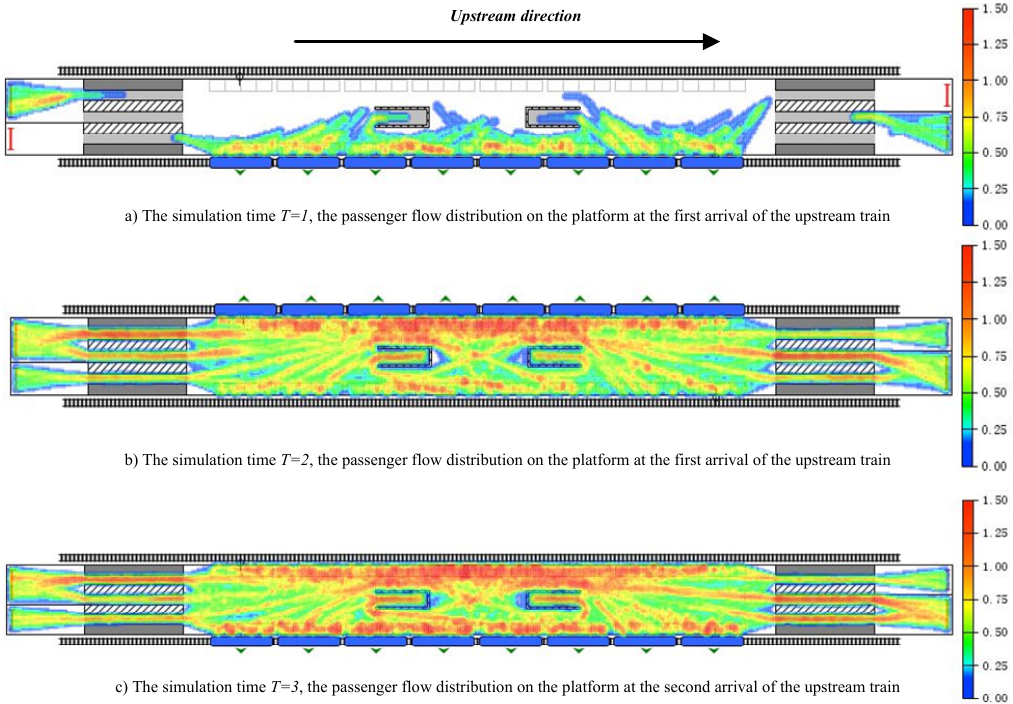
Figure 10. Location Distribution Map of Passenger Flow on Urban Rail Platform at Different Times.